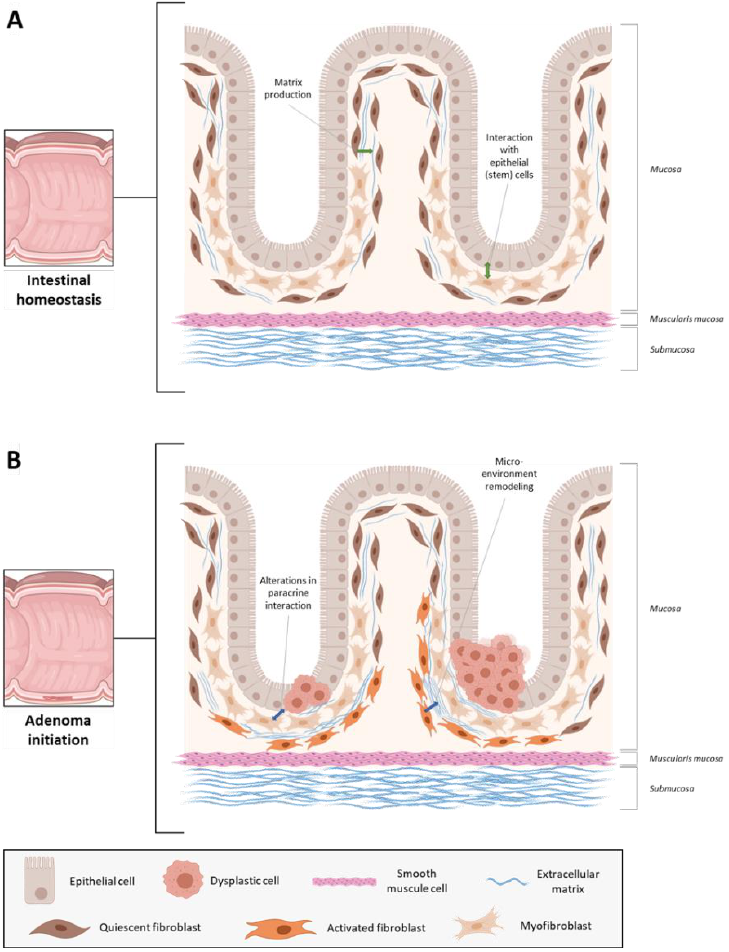
Figure 1. Fibroblasts in ( A ) intestinal homeostasis and ( B ) adenoma initiation. (Created with Bio- Render.com).